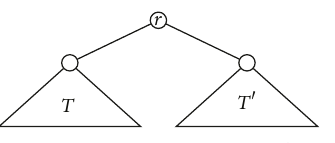
Figure 3: The root join 𝑇 ⋆ 𝑇 󸀠